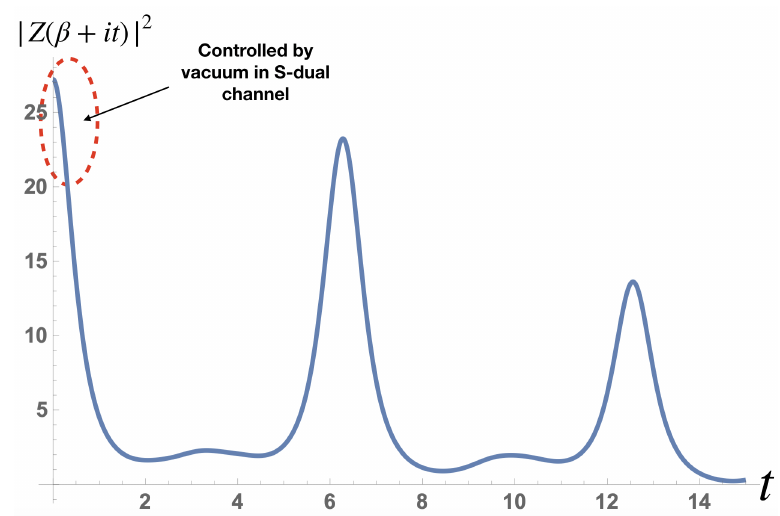
Figure 2: Spectral formfactor in 2d Ising ( β = 1). It represents a typical behavior: it is large at early times and the initial decay is controlled by the vacuum in the S- dual channel. After a certain time a recurrence, generically only partial, happens. In chaotic theories the recurrence time is typically very